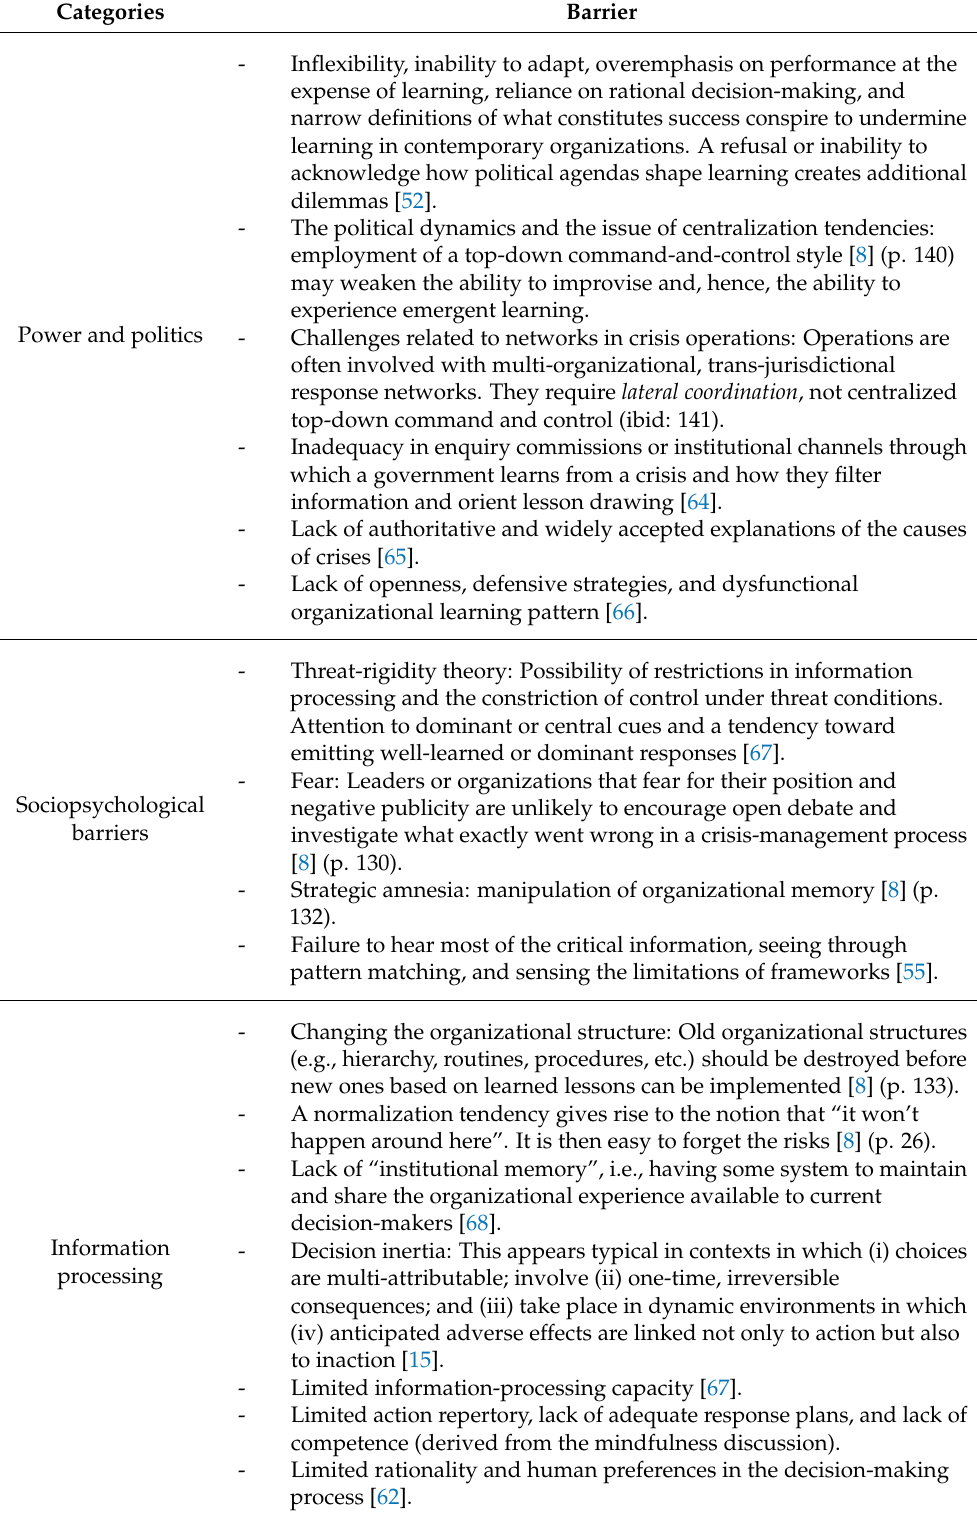
Table 1. Learning